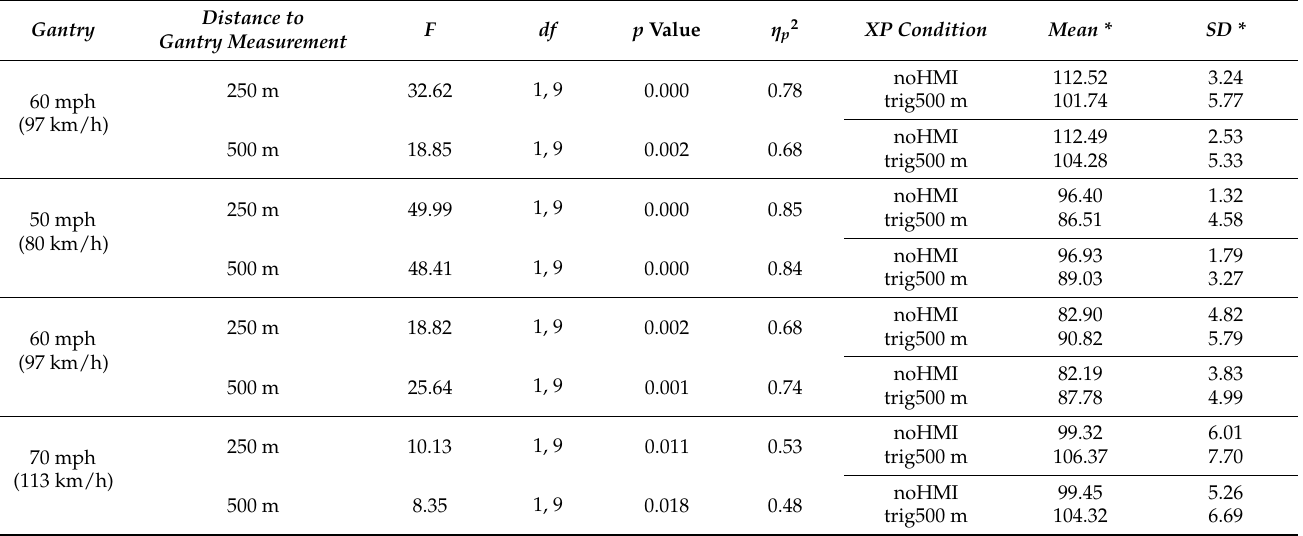
Table 7. Repeated measures ANOVA conducted to compare mean speeds between the noHMI and the trig500 m conditions for the same sequence of gantries. Scores reported in km/h.